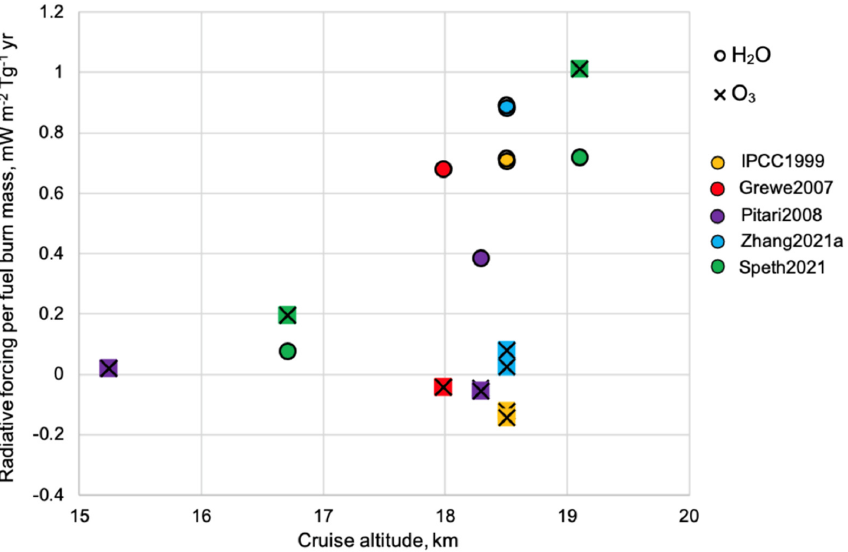
Figure 1. The global changes in RF per fuel burn mass (mW m − 2 Tg − 1 yr) versus cruise altitudes for changes in H 2 O and O 3 as reported by various studies. Discrepancies in the O 3 RF per burnt fuel can be caused by three effects: the inclusion or omission of ozone changes through aerosol emissions in different models; a different assumed emission index of NO x ; and different radiative transfer computations. Table 2. Overview on supersonic studies and their estimates of climate